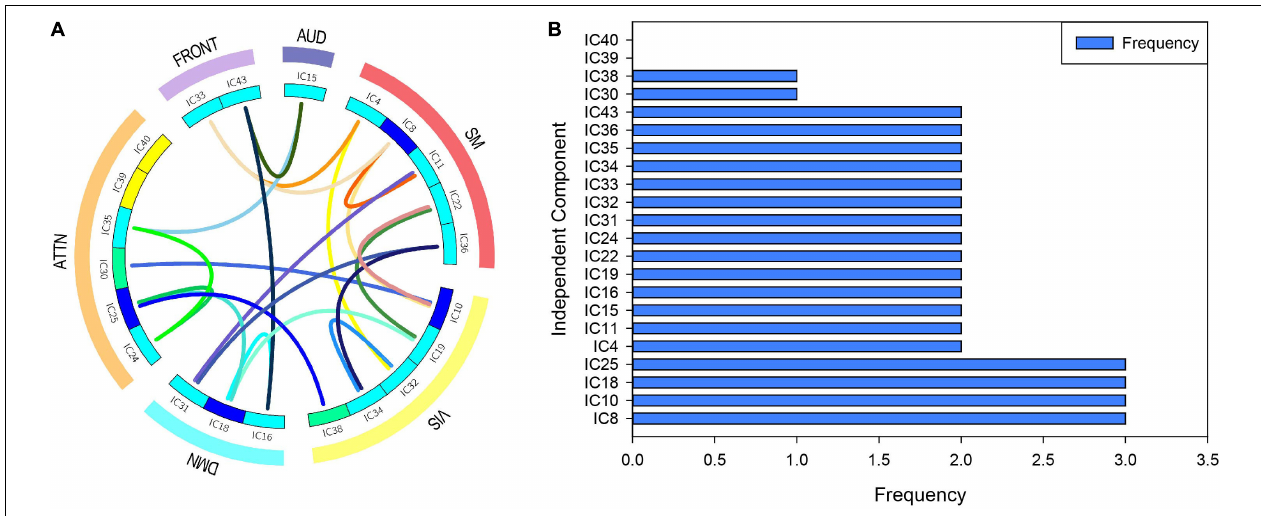
FIGURE 4 | Abnormal independent components of the local attribute features. AUD, auditory network; SM, sensorimotor network; VIS, visual network; DMN, default mode network; ATTN, attentional network; FRONT, frontal network. IC, independent component. (A) The independent components involved in the 21 differential functional connections. Edges of different colors indicate different functional connections. Nodes of different colors indicate the frequency of the component in all abnormal functional connections. (B) The number of occurrences for each independent component in the abnormal functional connection.